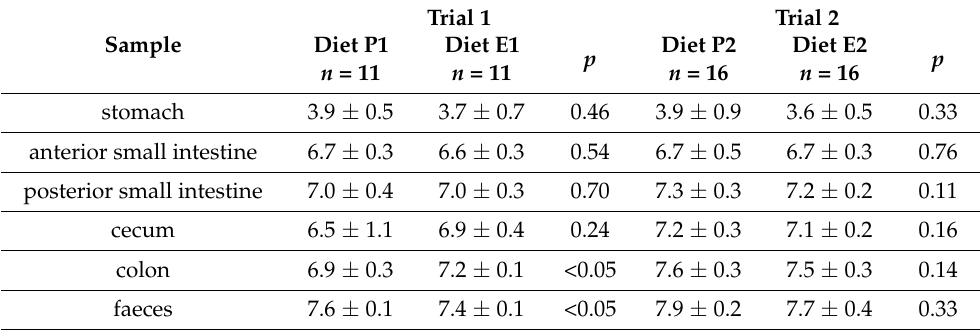
Table 3. Gastrointestinal and fecal pH values in trials 1 and 2 (mean ±